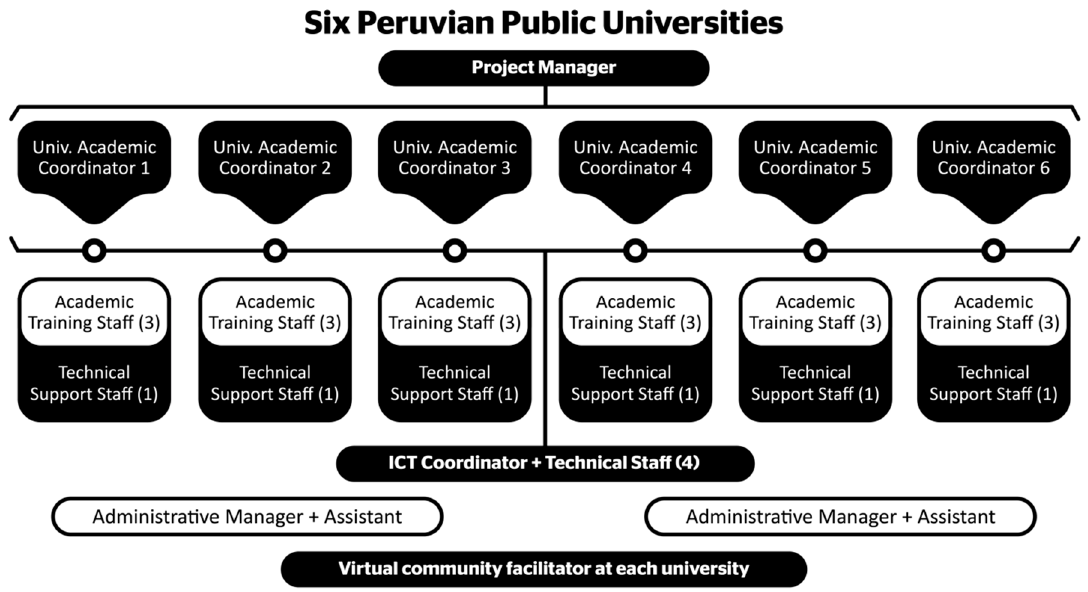
Figure 3. Organization chart for the consortium staff.